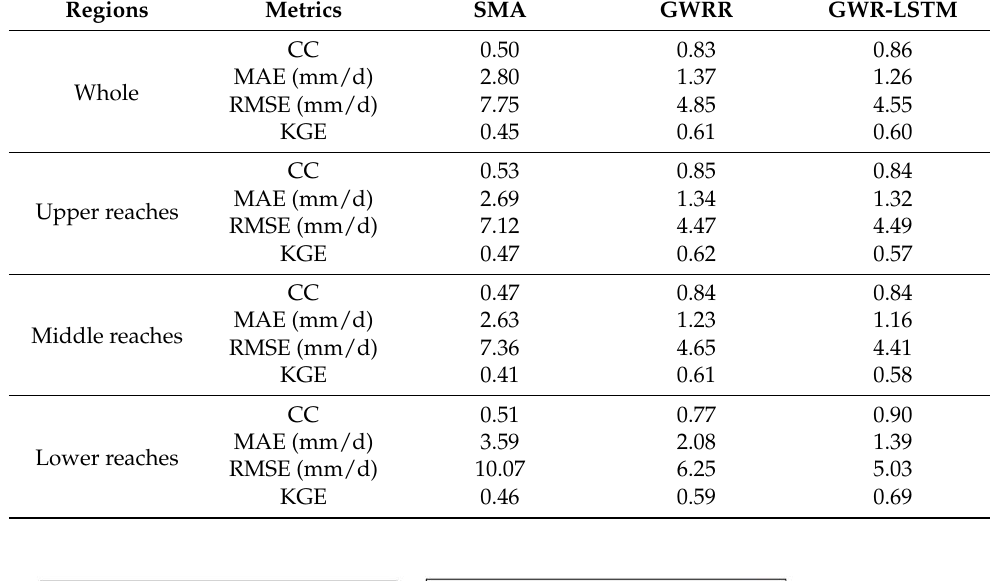
Table 6. CC, MAE, RMSE, and KGE of the GWR-LSTM framework proposed in this study and the traditional fusion model (SMA, GWRR) across the whole, upper, middle, and lower reaches of the Hanjiang River.